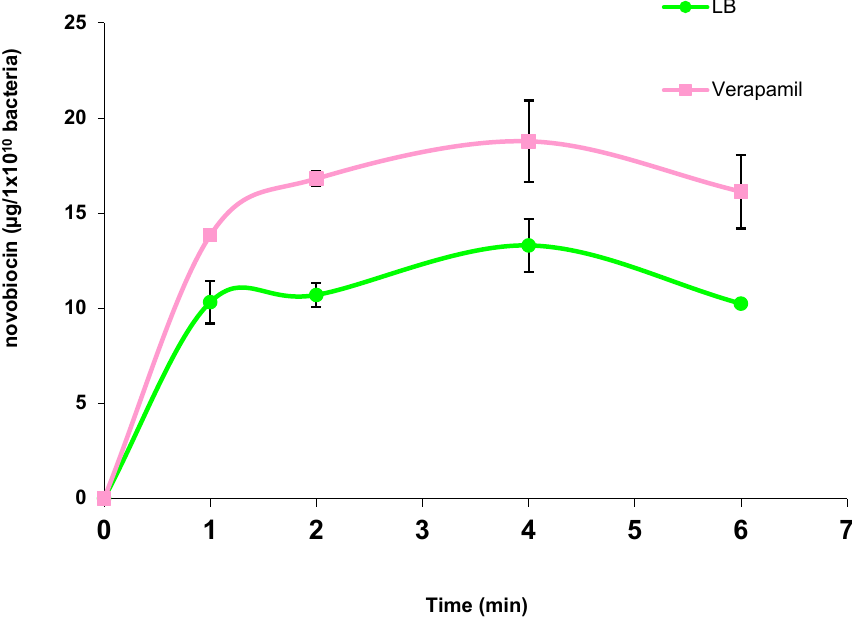
Figure 5. Kinetics of accumulation of novobiocin in the cytoplasm of P. aeruginosa PAO1 in the absence or presence of verapamil.